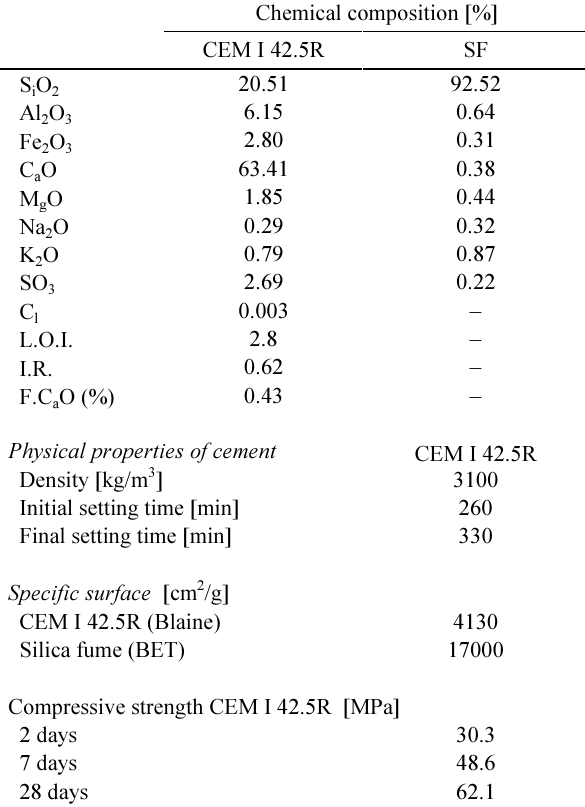
Table 1. Physical, chemical and mechanical properties of ce- ment and silica